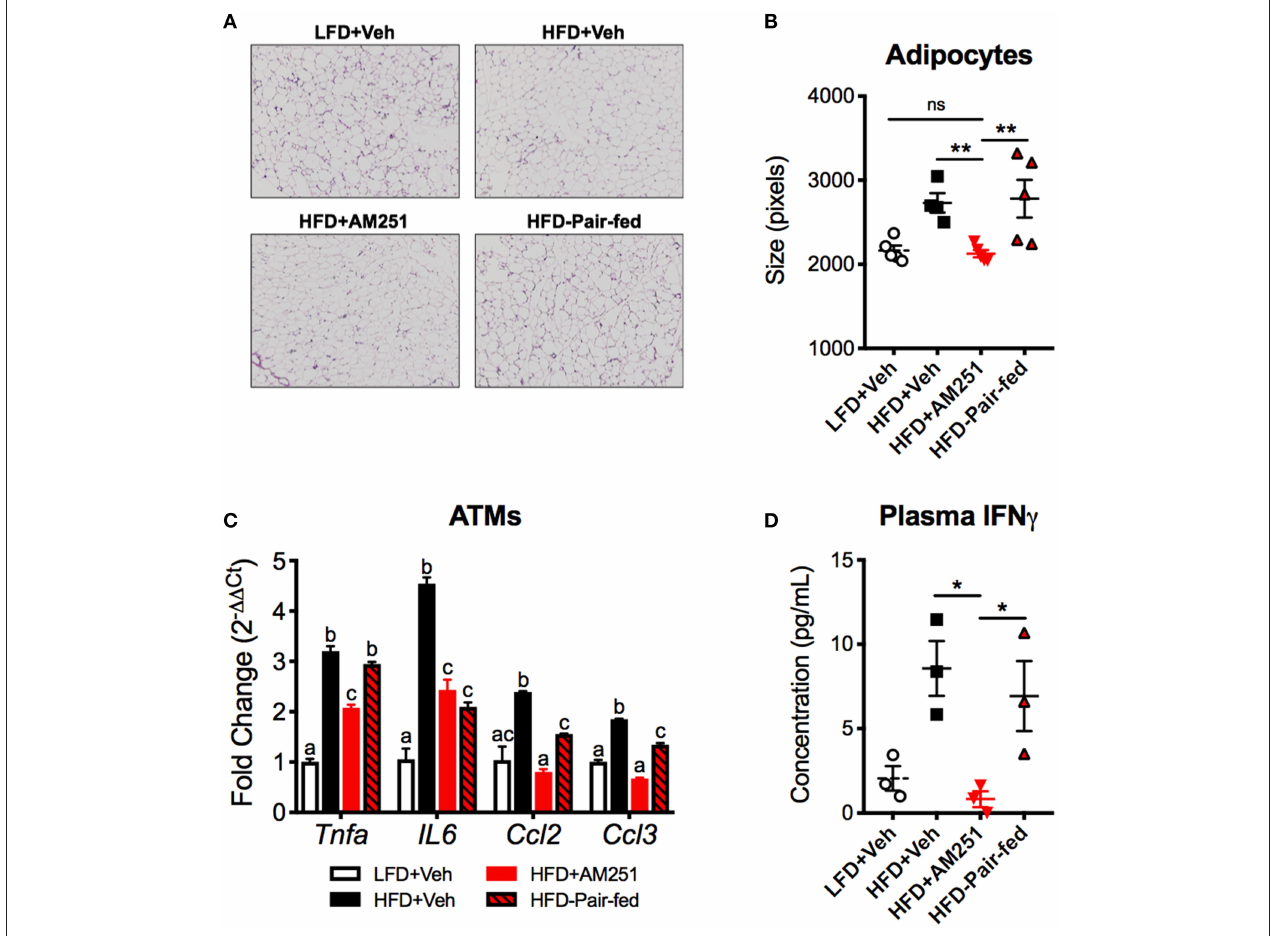
FIGURE 4 | AM251 treatment in vivo reduces energy storage and type 1 inflammation associated with DLL4-Notch signaling. HFD-fed obese mice were treated with AM251 (10 mg/kg) for 4 weeks as described in Figure 1 legend. Adipocyte size, ATM gene expression, and plasma IFN γ were quantified in mice after the 4-week AM251 intervention. (A) Representative H & E stains of epididymal fat. Images are to equal scale (4X). (B) FIJI adipocyte size quantification. (C) qRT-PCR expression of inflammatory cytokine/chemokine genes in F4/80 + ATMs. (D) Plasma IFN γ concentration measured by ELISA. Data are mean ± SEM. For (A,B) , N = 4–5 mice/group. For (C) , data are presented from a single experiment of 4–10 pooled mice per group. For (D) , N = 3 independent experiments of pooled plasma from 4 to 10 mice/group. Significance was determined by one-way ANOVA. ** P < 0.01, * P < 0.05. For (C) , p < 0.05 if alphabetical characters differ between groups.